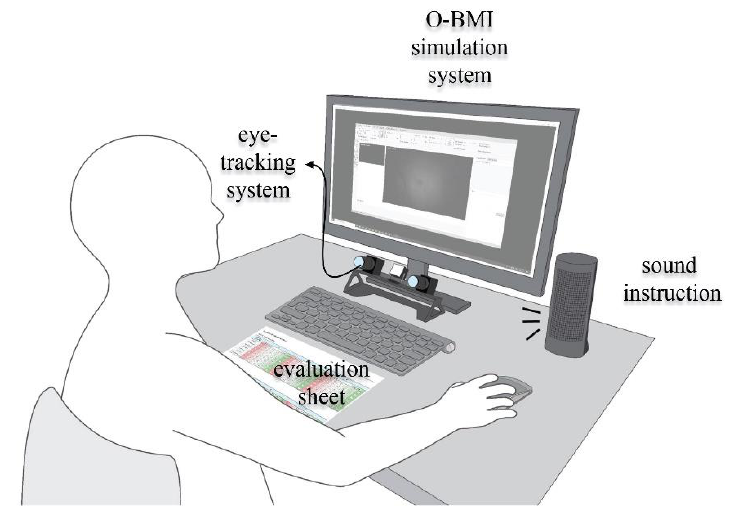
Figure 7. Experiment setup for usability testing of O-BMI systems.